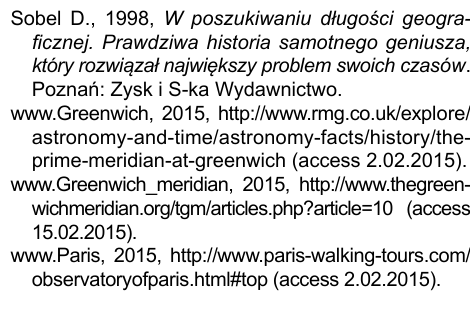
editions of atlases just a few maps with the Ferro Meridian appeared, and only in one of them [25] it was used as the only one. After 1930, only the Greenwich Meridian and the description of the longitude 180° east and west